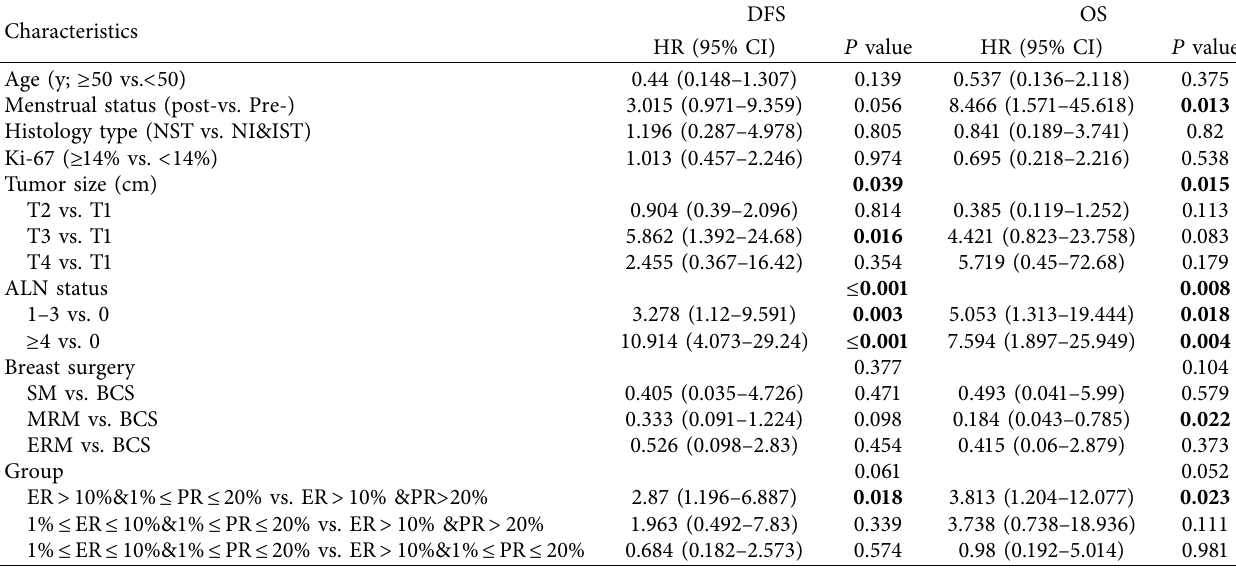
Table 3: Multivariate analysis of factors associated with DFS and